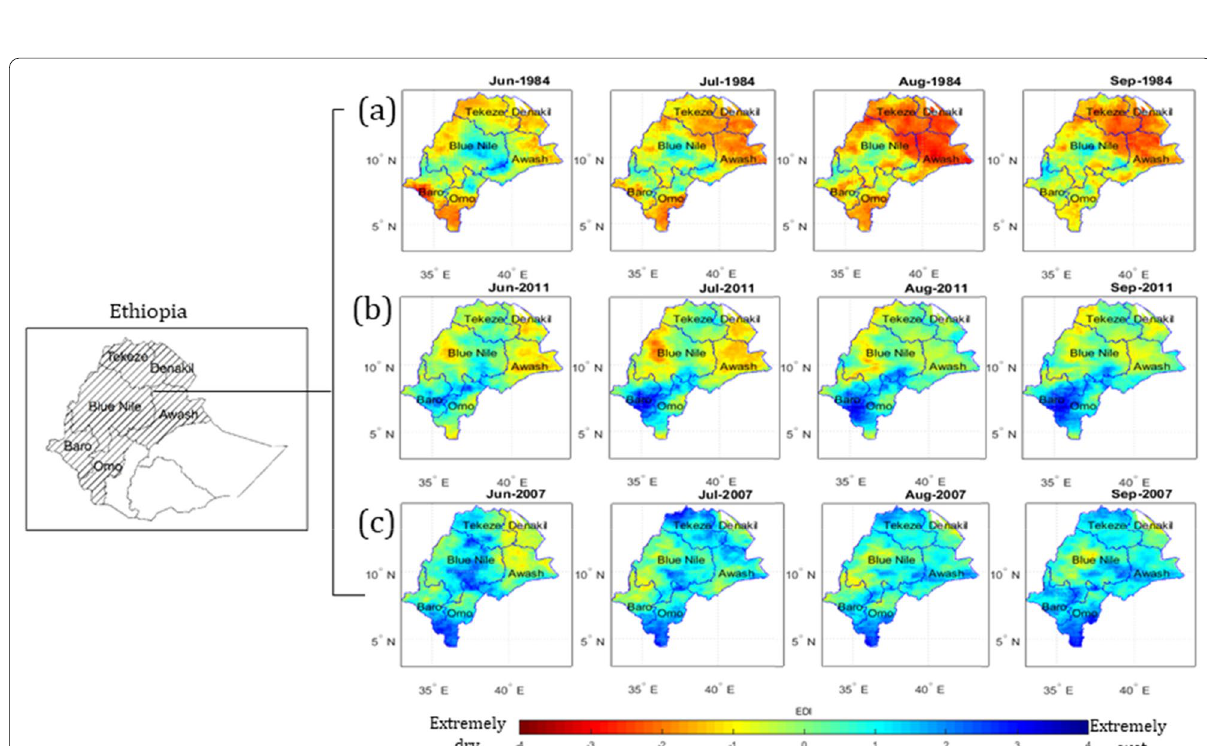
Fig. 6 Spatial pattern of monthly EDI values in selected river basins during smaller rainfall months in ( a ) 1984 drought year ( b ) 2011 drought year and ( c ) 2007 non-drought year